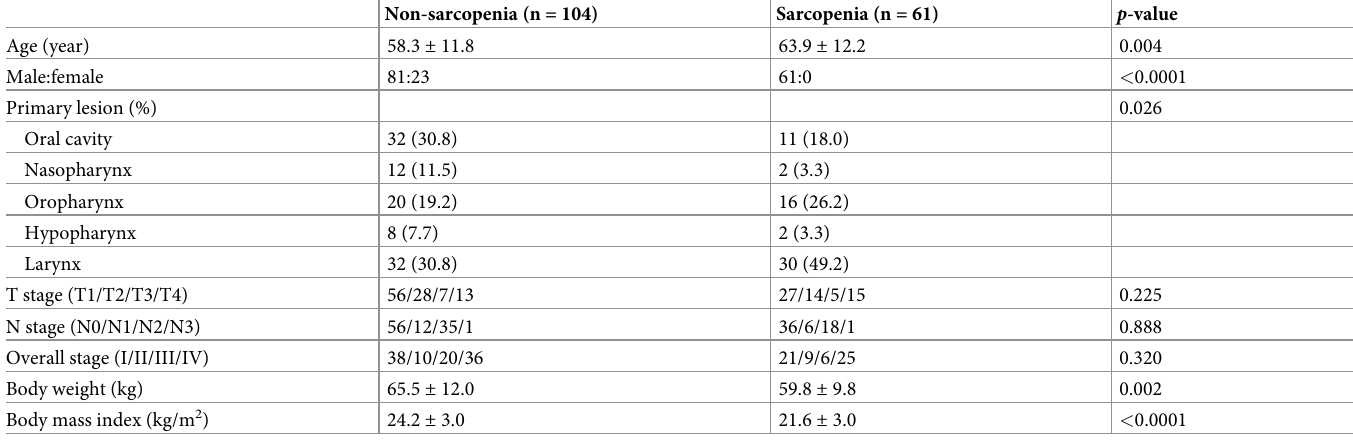
Table 2. Comparison of clinical characteristics between patients with or without